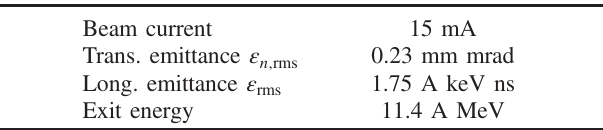
TABLE VI. Beam output parameters of the 85 MV heavy ion linac.